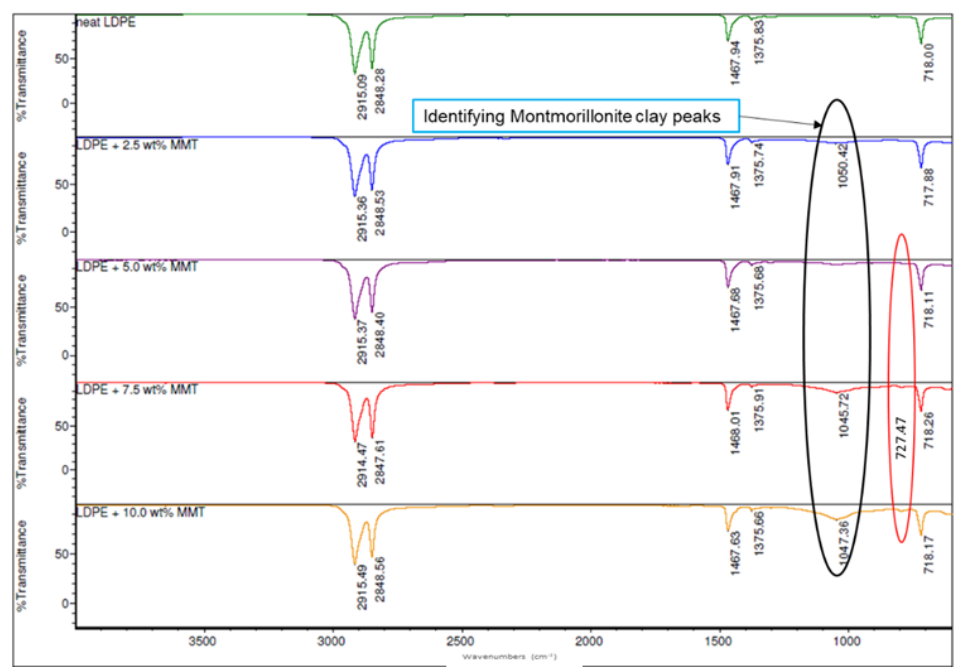
Figure 6. Comparison of ATR-FTIR spectra of LDPE and LDPE/MMT nanocomposites.